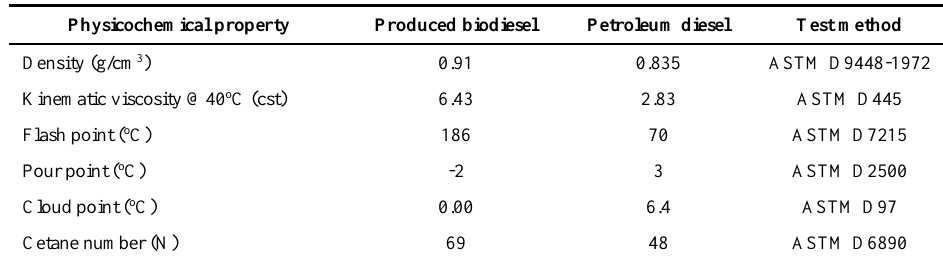
Table 3. Fuel properties of the biodiesel and petroleum diesel